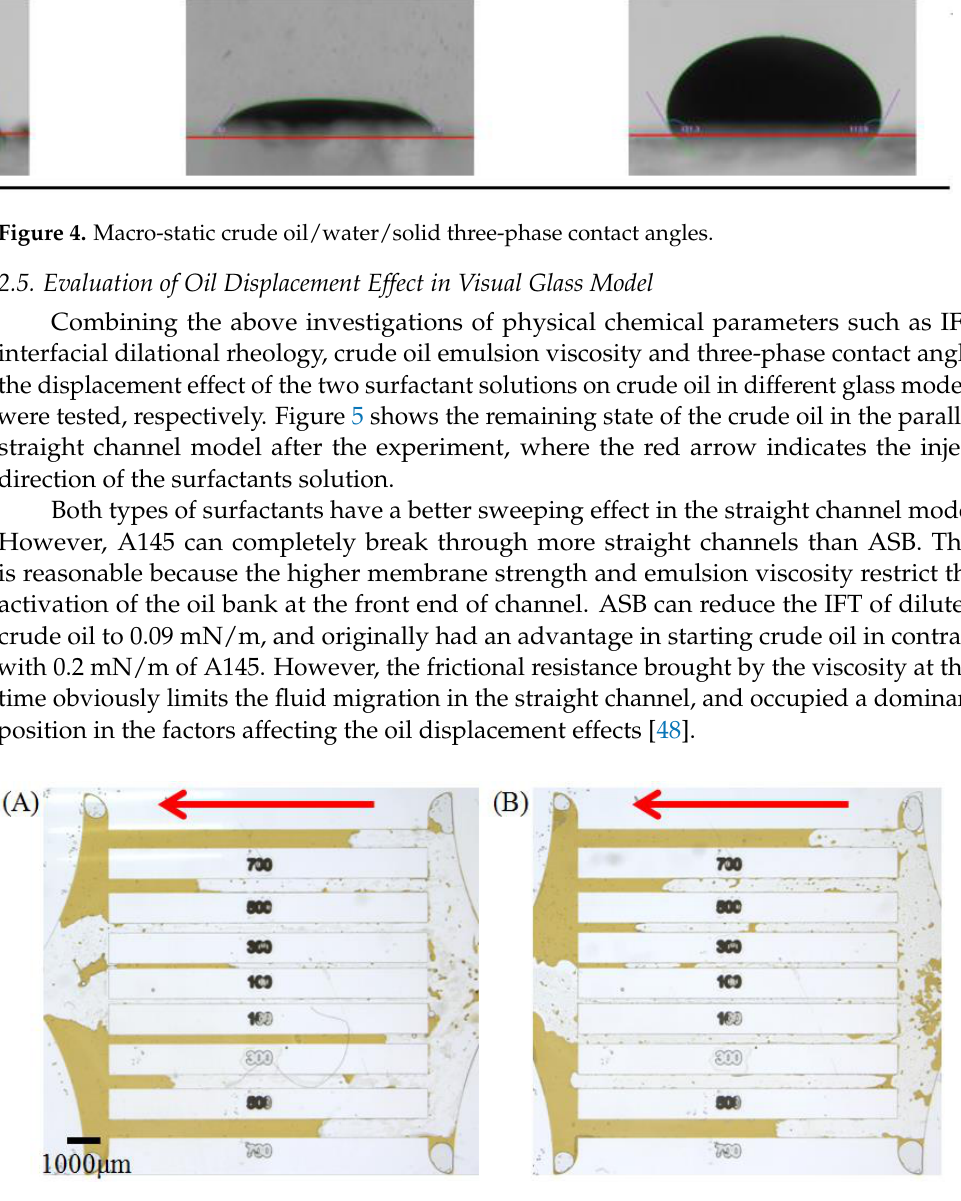
Figure 5. The final state of crude oil displacement of ASB ( A ) and A145 ( B ) solutions in parallel straight channel model.